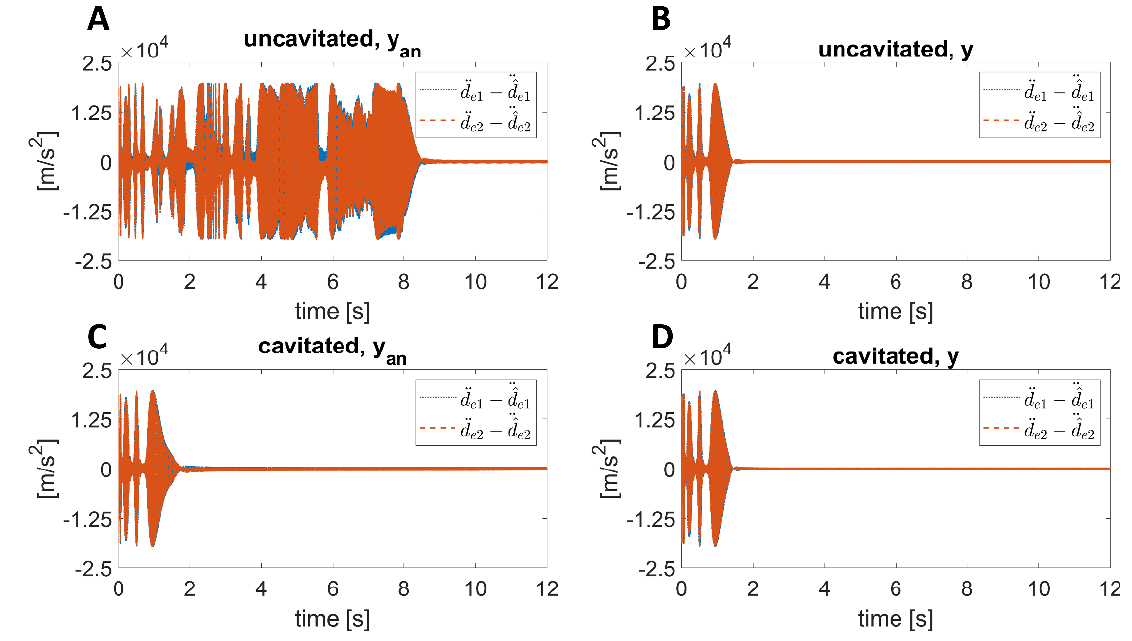
.. (cid:101) d ei ( t , ω ) are reported for uncavitated and cav-